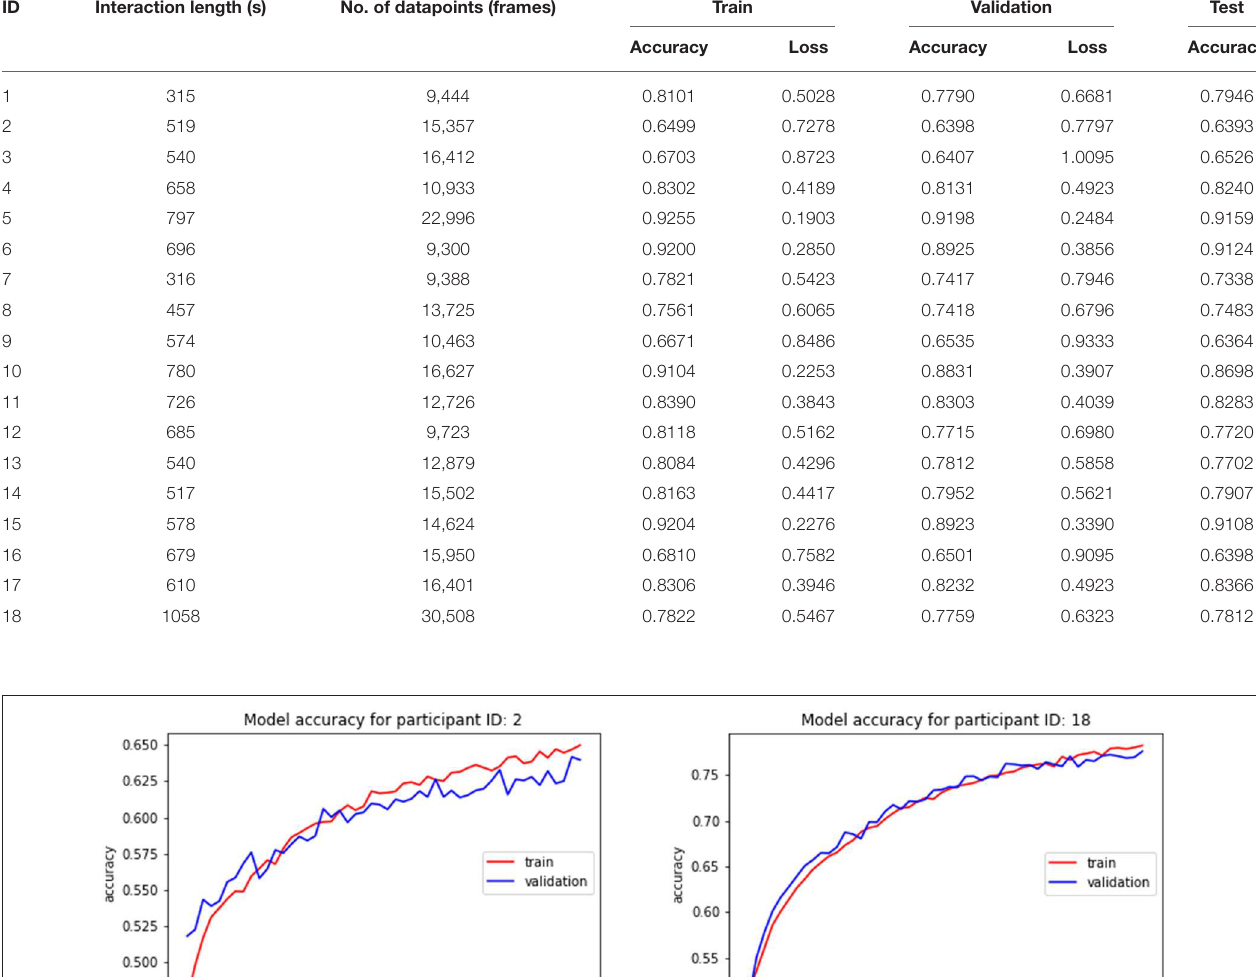
TABLE 3 | Performance metrics for the individual classifiers (TD Group: ID1–ID13, ASD Group: ID14–ID18). ID